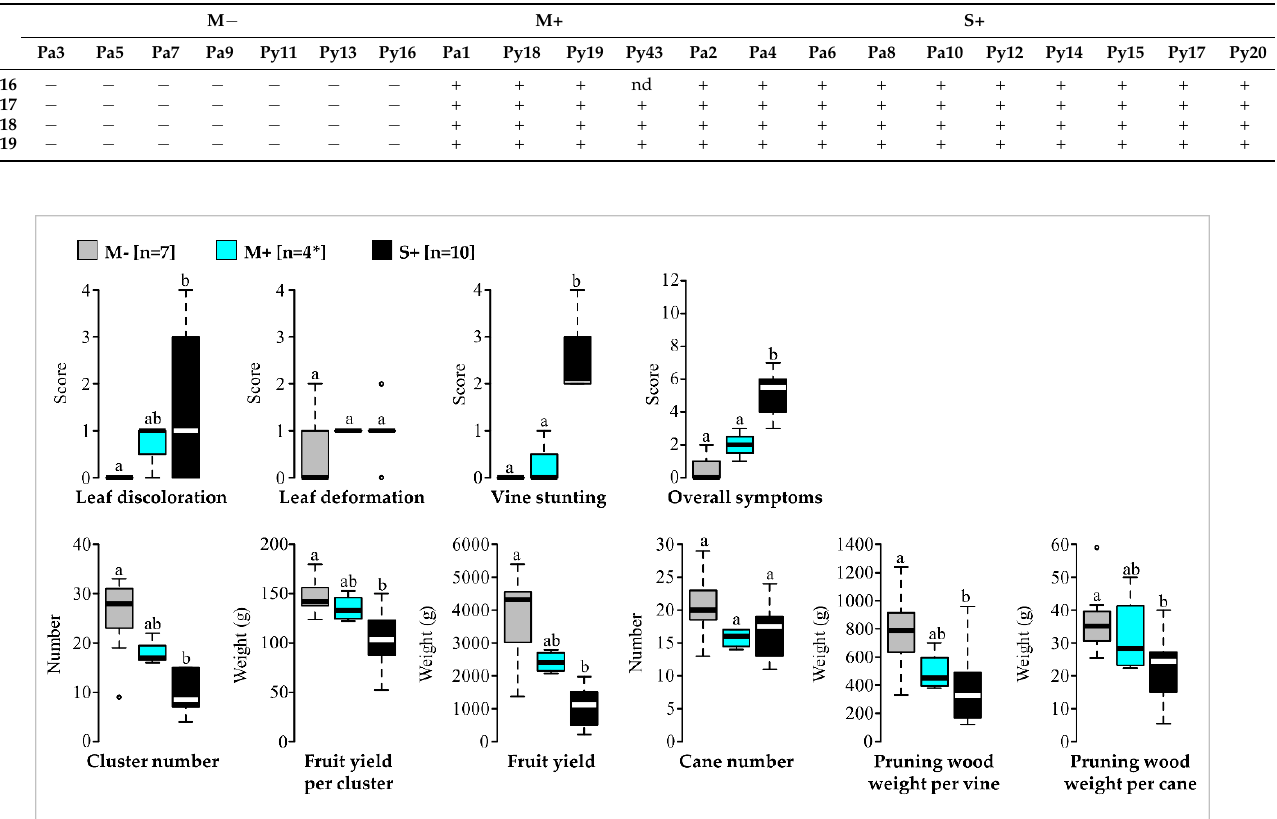
GFLV-infected vines) and S+ (severe symptomatic, GFLV-infected vines). The presence/absence of GFLV in vine Py43 was only tested starting in 2017 as this plant was only identified in autumn 2016 (nd: not determined).